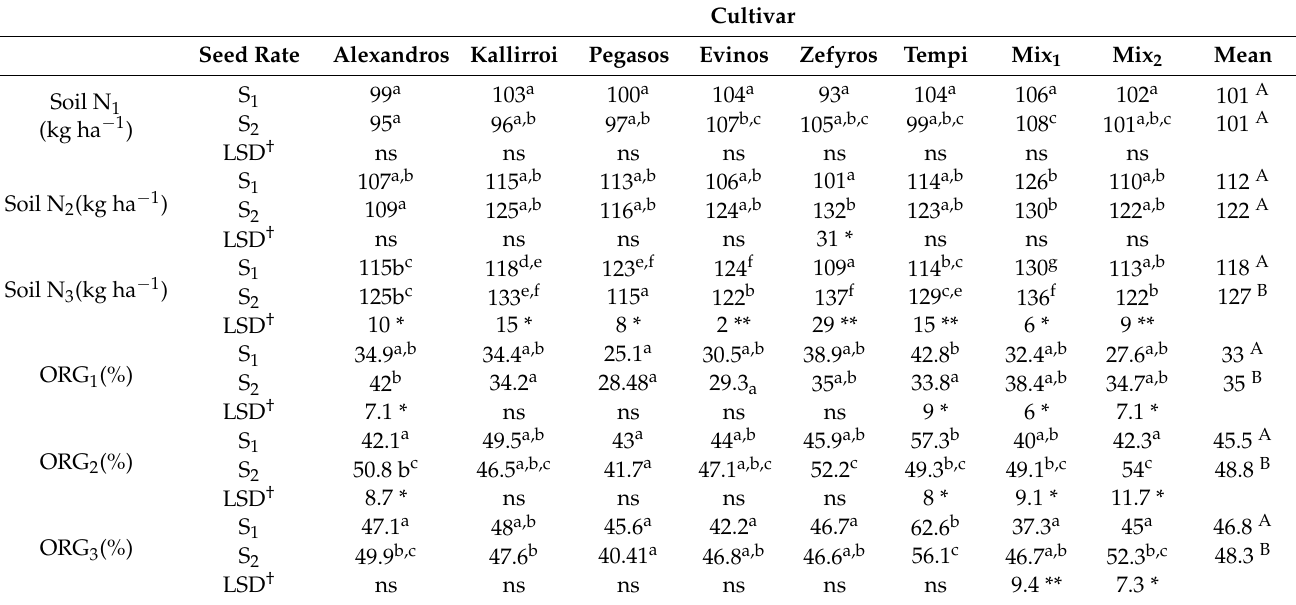
Table 4. Soil nitrogen and soil organic matter at two, four and six months after the incorporation of Vicia sativa plants at two seed rates (S 1 , S 2 ) for each cultivar and cultivar mixture. Different letters indicate significant differences between/among means of cultivars grown at the same seed rate at p < 0.05, according to Tukey’s method, and LSD † indicates significant differences between seed rates within the same